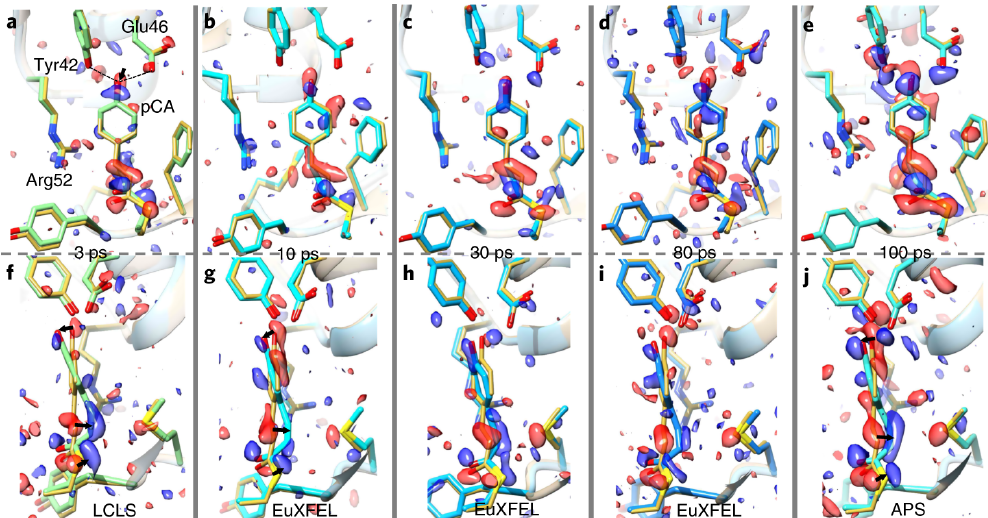
Figure 12. A Time series of the chromophore binding region of photoactive yellow protein (PYP) between 3 and 100 ps. A difference electron density map is shown in red ( − 3 σ contour level) and blue (+3 σ contour level). Images ( a – e ) show a “front” view, images ( f – j ) show a side view. Arrows highlight regions of displacement. Figure originally published in Nat. Methods